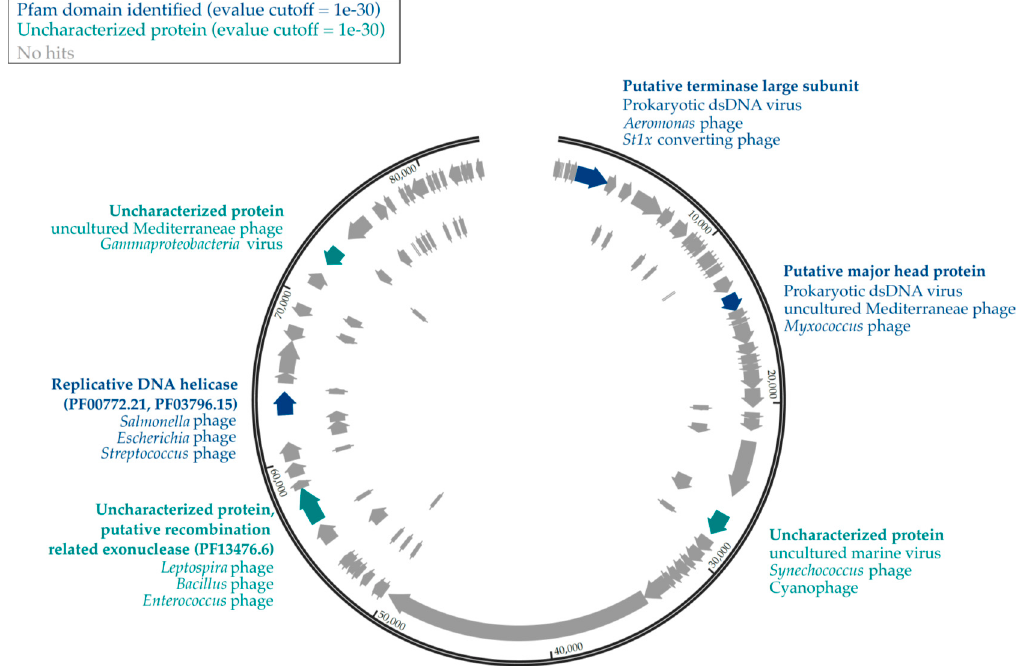
Figure 2. Genomic map of UViG11. Pfam-identified proteins and lineage of best hits are shown in dark blue. Uncharacterized proteins which had an e-value <1 × 10 − 30 are presented in teal, and proteins with no hits in the UniProtKB database are in gray.